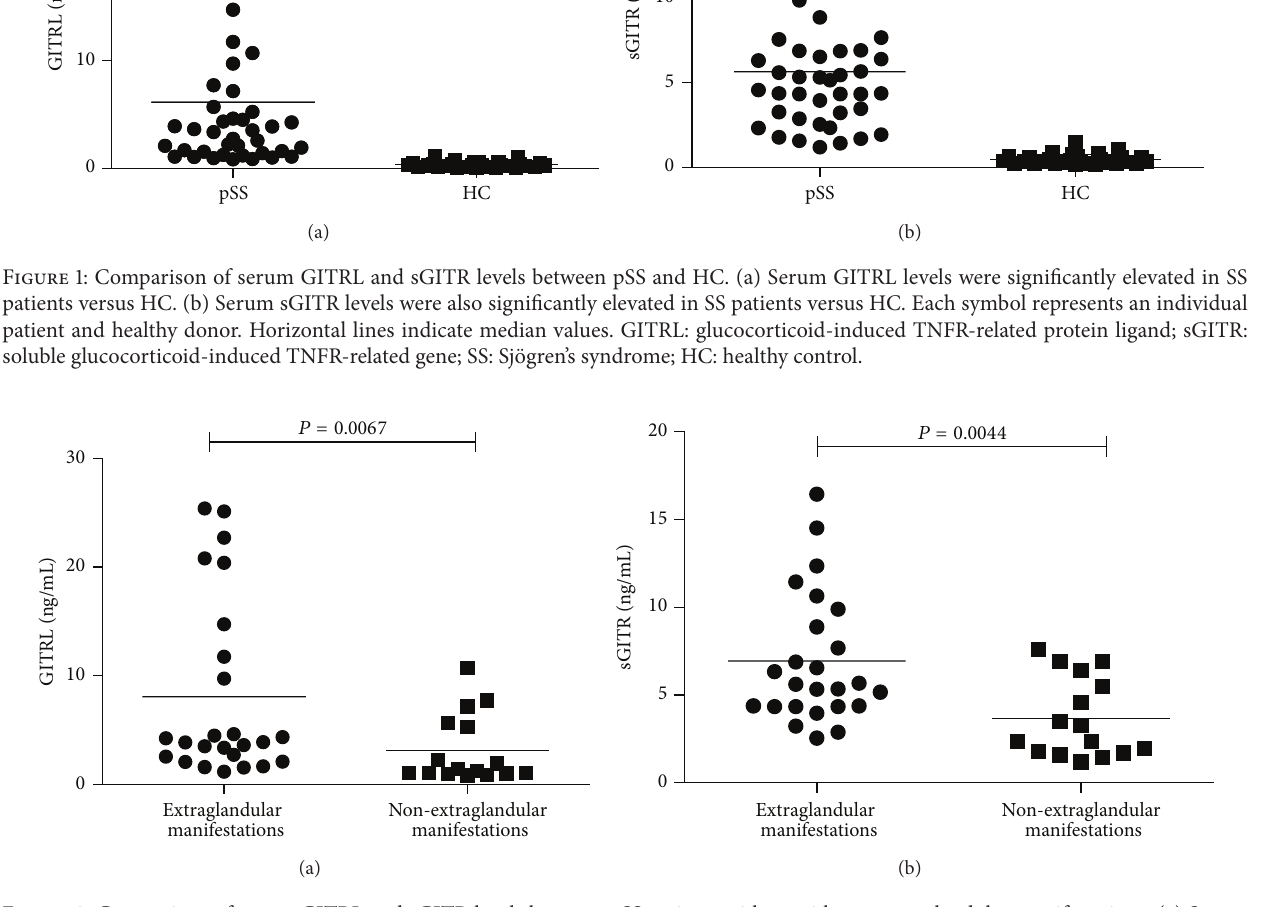
Figure 2: Comparison of serum GITRL and sGITR levels between pSS patients with or without extra-glandular manifestations. (a) Serum GITRL levels exhibited elevation in pSS patients with extra-glandular manifestations ( 𝑛 = 25 ) relative to patients without extra-glandular manifestations ( 𝑛 = 16 ). (b) Serum sGITR levels were also higher in pSS patients with extra-glandular manifestations ( 𝑛 = 25 ) than patients in the absence of extra-glandular manifestations ( 𝑛 = 16 ). Each symbol represents an individual patient; horizontal lines indicate median